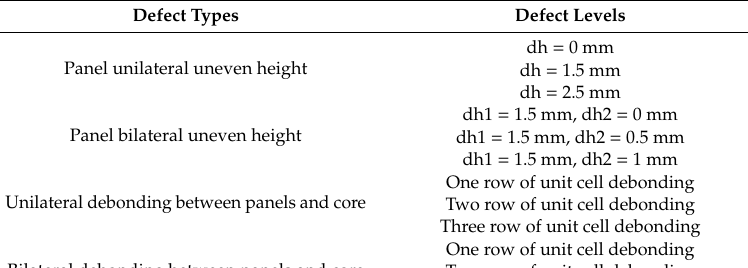
Figure 9. Schematic diagram of defects in aluminum honeycomb panel. Table 3. Defect types and defect level.